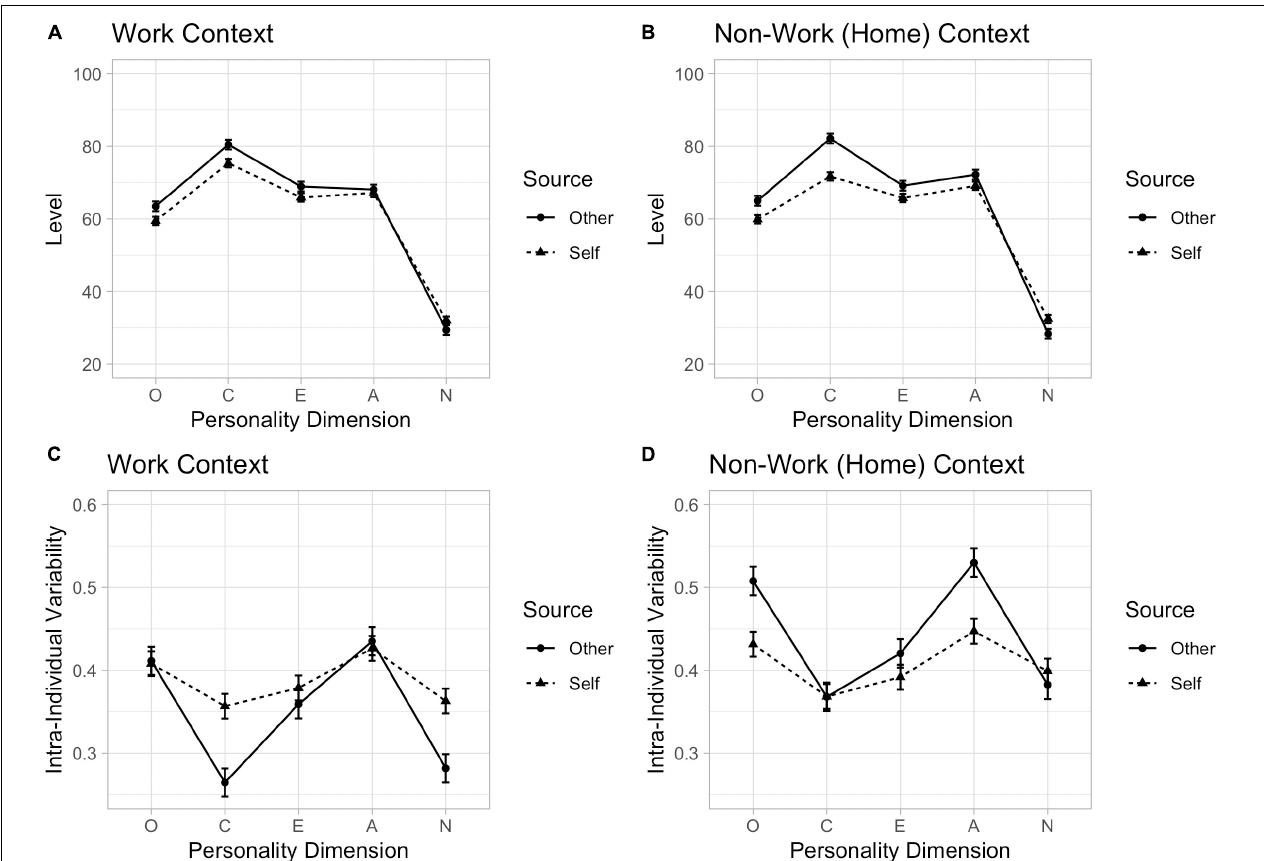
FIGURE 4 | Participant personality dimension mean in work (A) and non-work (B) contexts and intra-individual variability in work (C) and non-work (D) contexts, by self and others. Potential variable range: level = 0–100; intra-individual variability (relative standard deviation) = 0–1.